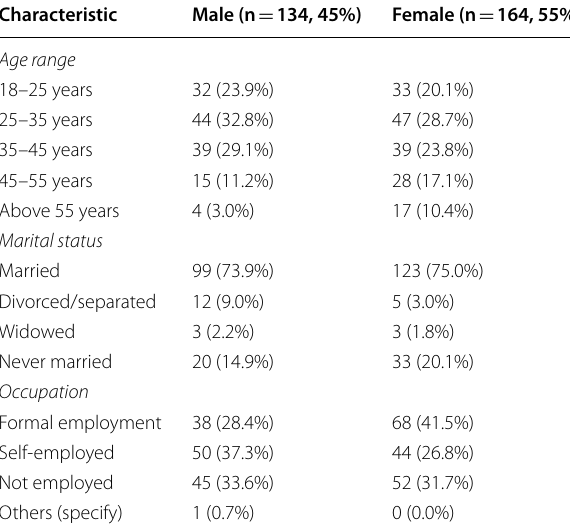
Table 1 Demographic characteristics of the study participants Table 2 Informal payments according to the demographic